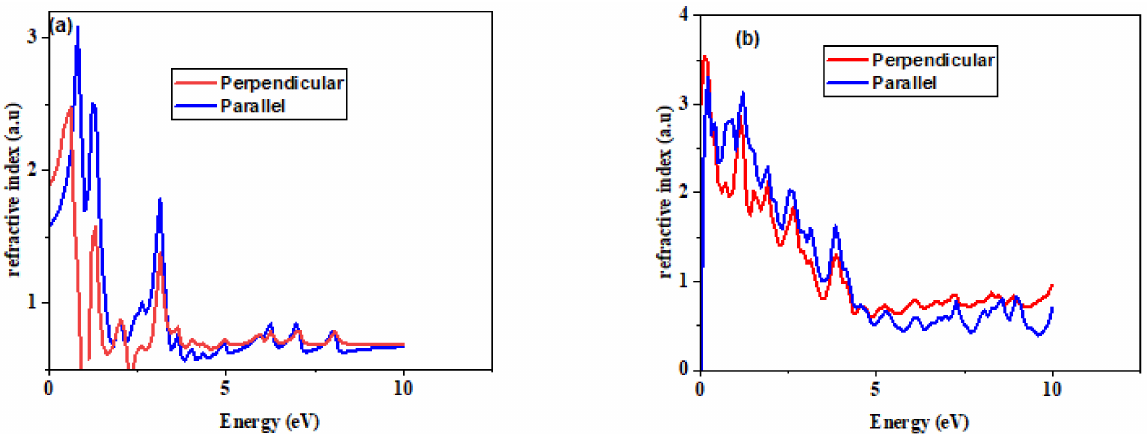
Figure 8. The optical refractive index of ( a ) armchair (5, 5) SWBNNT and ( b ) armchair (5, 5) SWCNT structures.